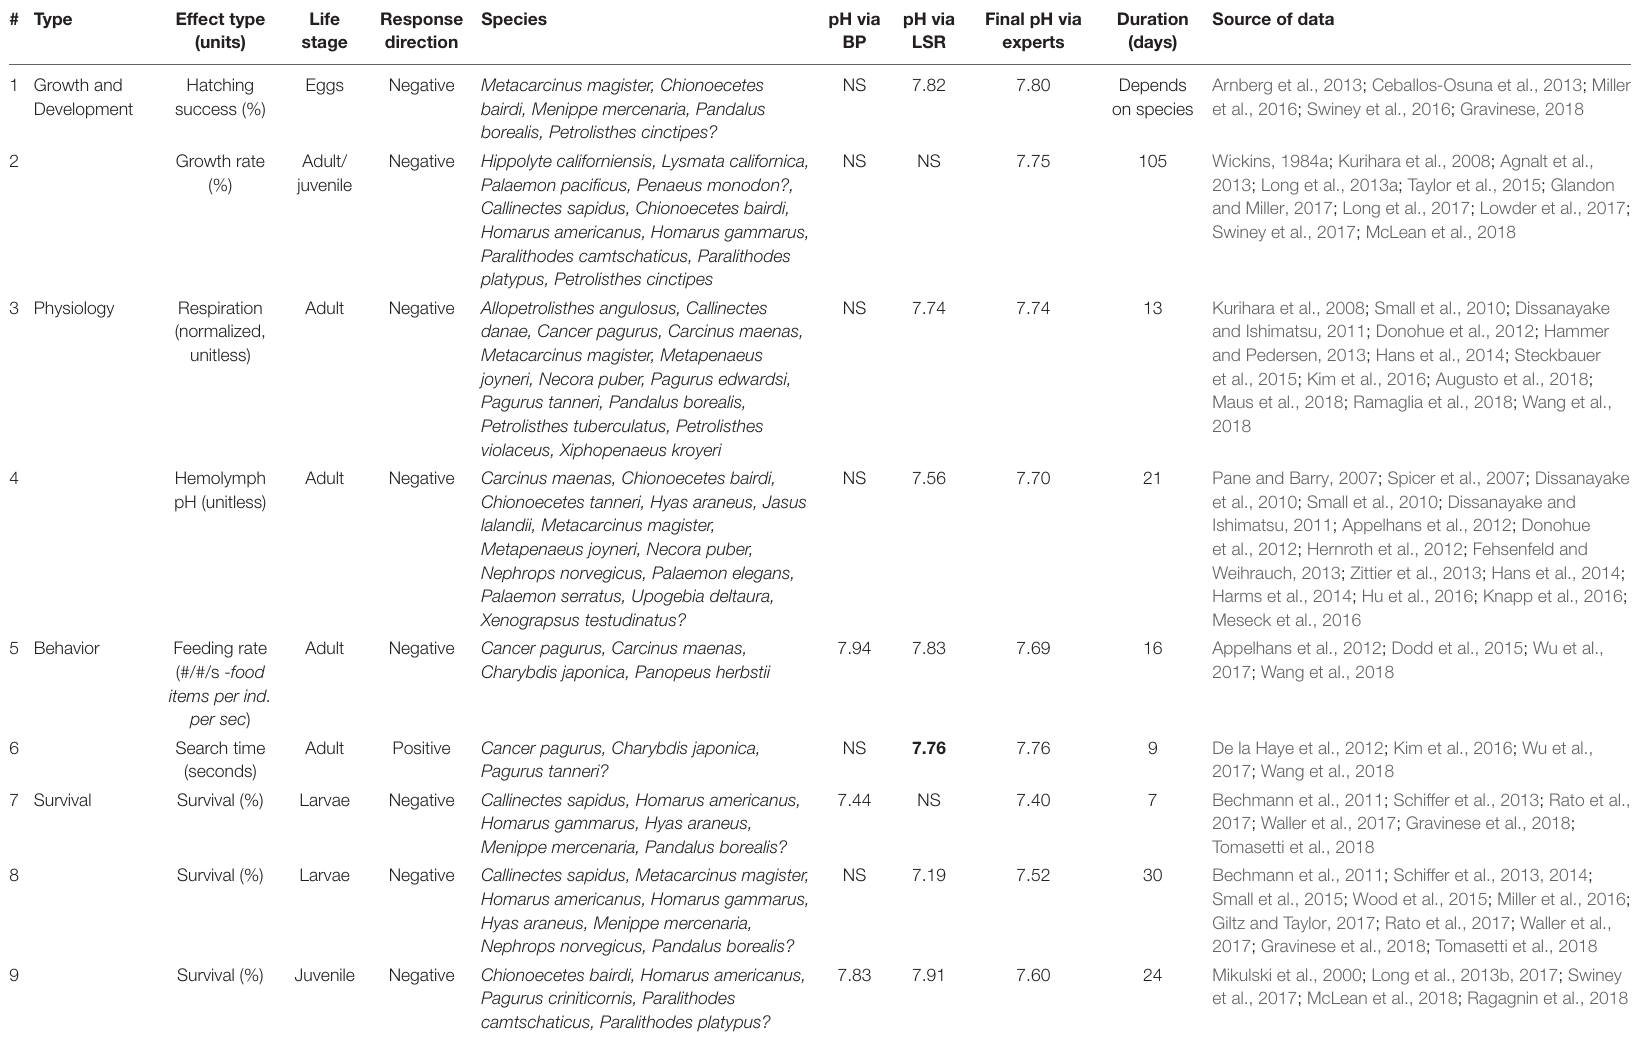
TABLE 2 | Summary of threshold results, including the threshold numbers (corresponding to number in Figure 3 ), effect group (physiology, growth and development, behavior, mortality) and specific effect with associated units, life stage, direction of response (negative or positive effect), habitat, species used in the